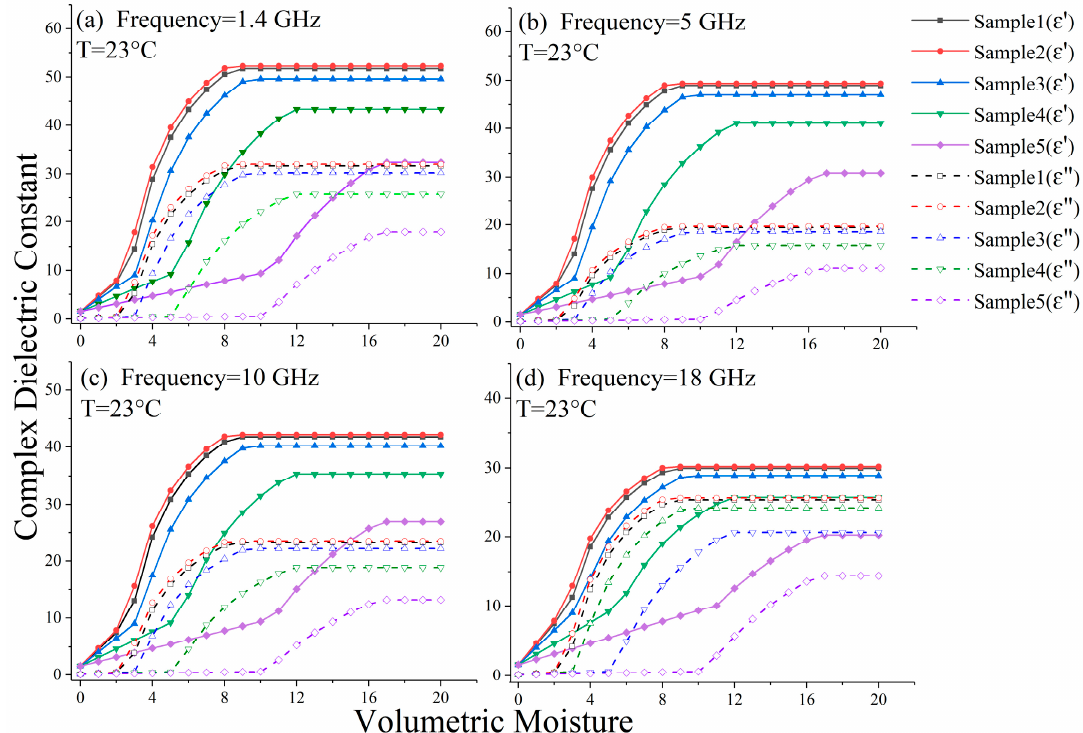
Figure 6. The moisture dependence of the dielectric constant for bound water of five types of soil at frequencies of ( a ) 1.4 GHz, ( b ) 5 GHz, ( c ) 10 GHz, and ( d ) 18 GHz; the indicated moisture range for each soil extends between 0% and 20%; the first turning point of each curve is the maximum strongly bound water content ( V maxsb ), and the second turning point is the maximum bound water content ( V maxb ); the curves were drawn based on the results from the Equation (13); physical properties of soils are shown in Table 1.